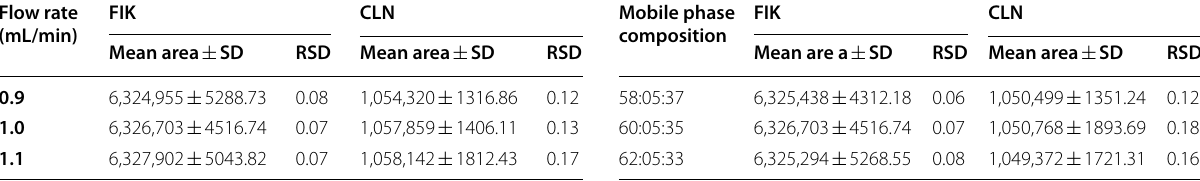
Table 5 Result for change in flow rate (